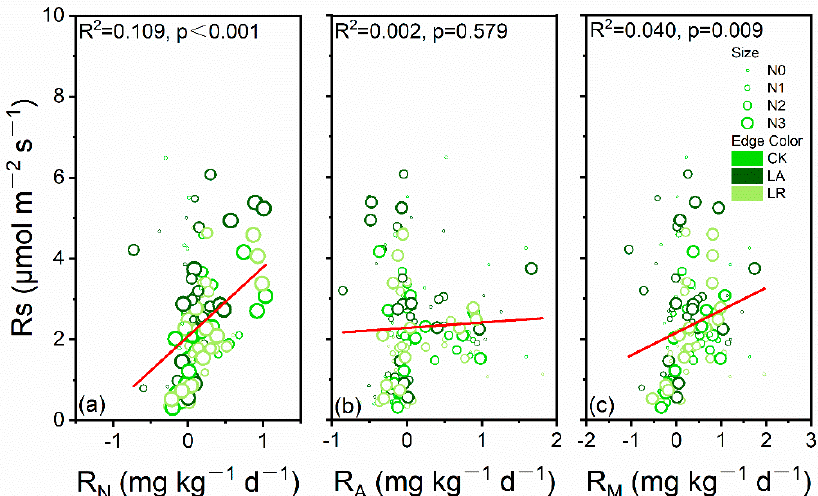
Figure 5. The linear relationships between soil respiration (Rs) rates and net nitrification (R N ) rates ( a ), ammonification (R A ) rates ( b ), and mineralization (R M ) rates ( c ) under different N fertilizer and litter input treatments ( n = 144).